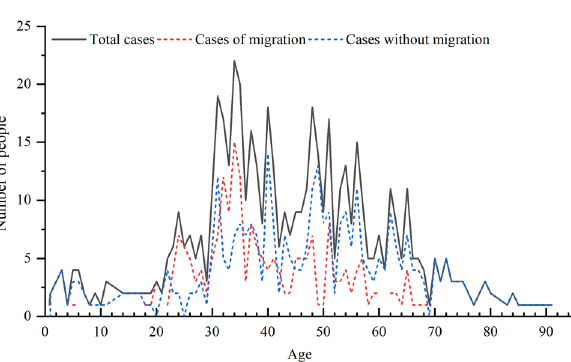
Figure 3. Age distribution characteristics of confirmed COVID-19 cases in Shandong